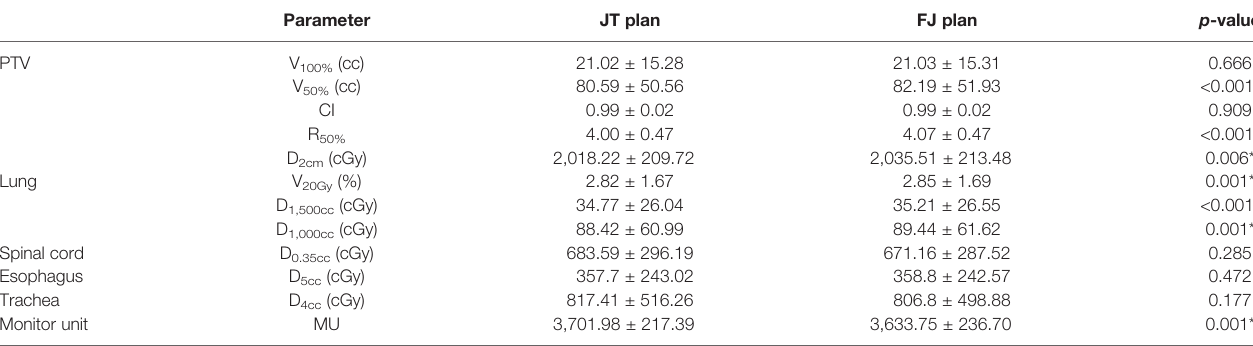
TABLE 1 | Comparison between jaw tracking (JT) and fi xed-jaw (FJ) plans. The data are shown in mean value ± standard deviation, along with the Wilcoxon signed- rank test p